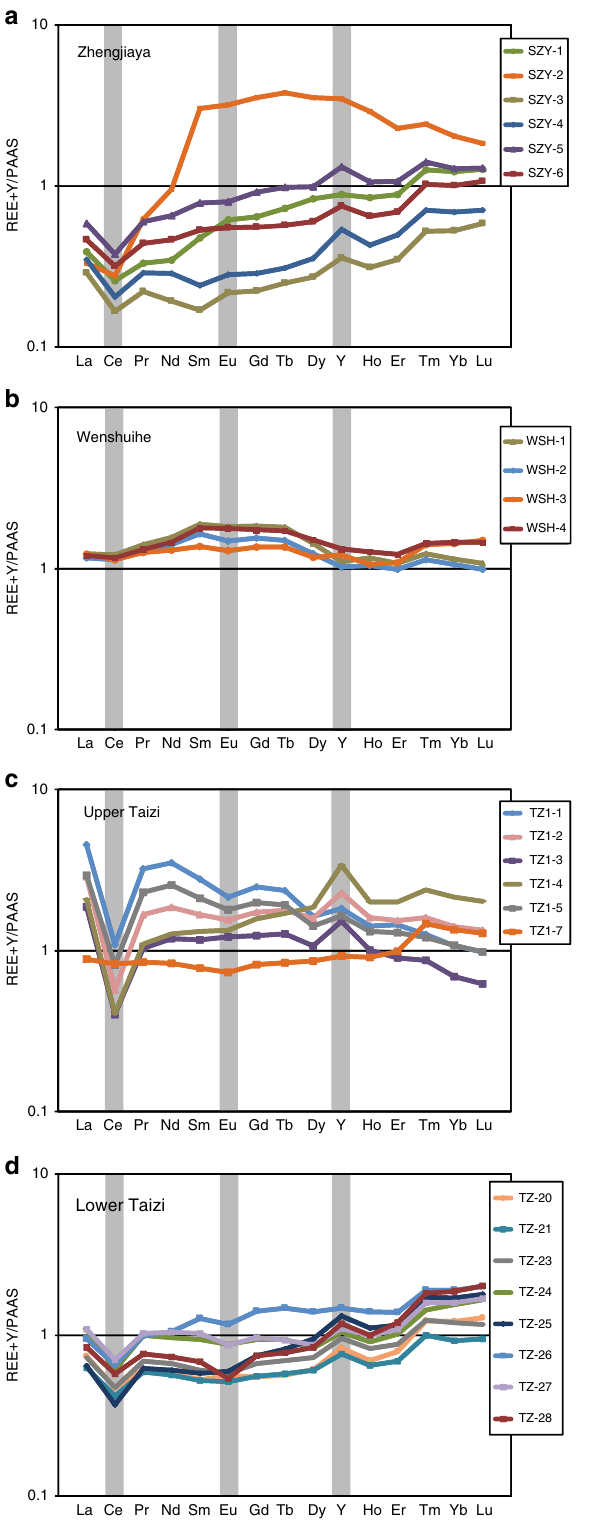
Fig. 5 Rare earth element plus yttrium patterns for samples with elevated δ 53 Cr from the Shennegjia Group normalized against post Archean average shale (PAAS). The gray boxes highlight the elements Ce, Eu and Y